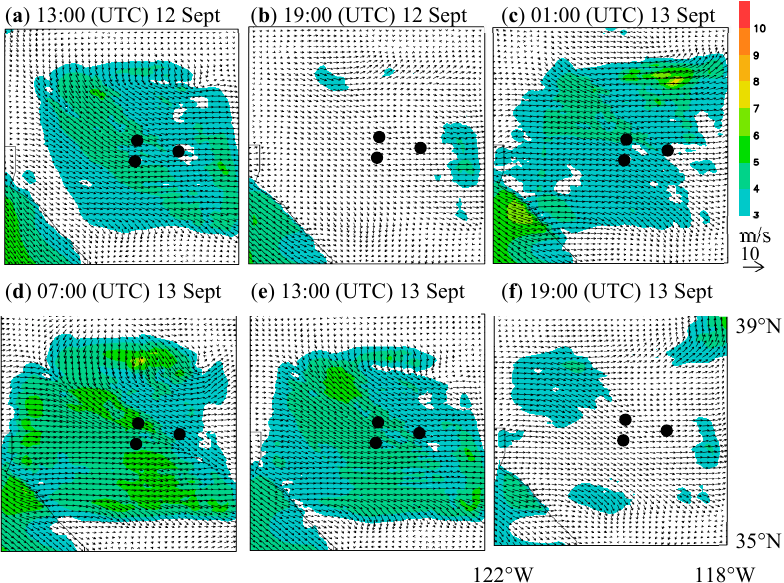
Figure 10. Near-ground wind behavior in Area-S with topographical effects removed, simulated using a regional SCALE model (resolution of 5 km × 5 km). Images are given for each 6-hour period between 13:00 (UTC) on 12 September and 19:00 (UTC) on 13 September 2020 ( a – f ). The black dots denote the three AERONET observation sites.